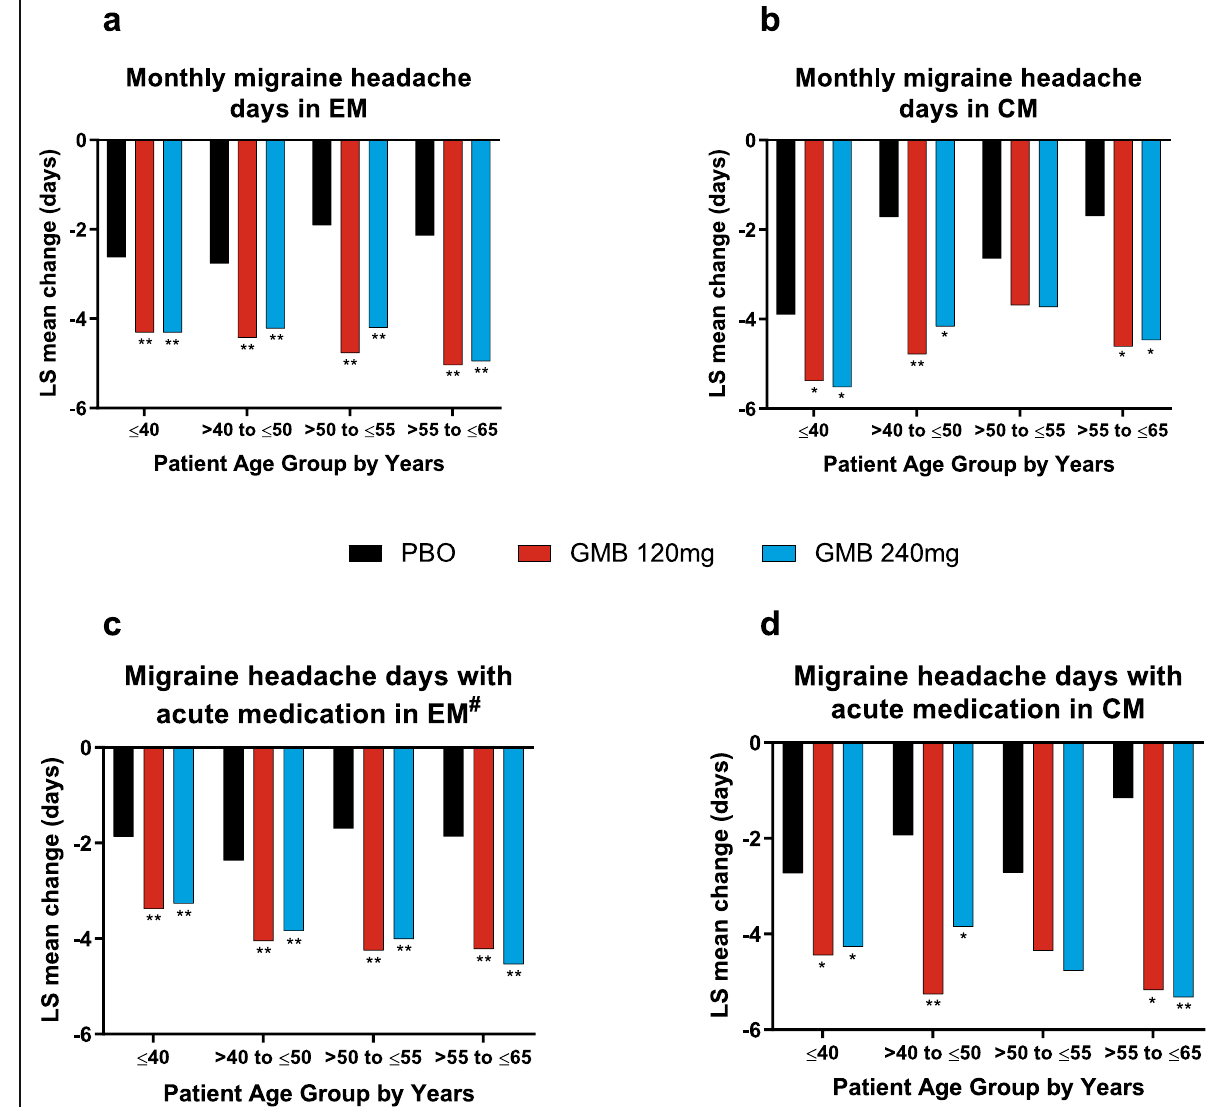
Fig. 2 Reduction in migraine headache days and migraine headache days with acute medication, by age